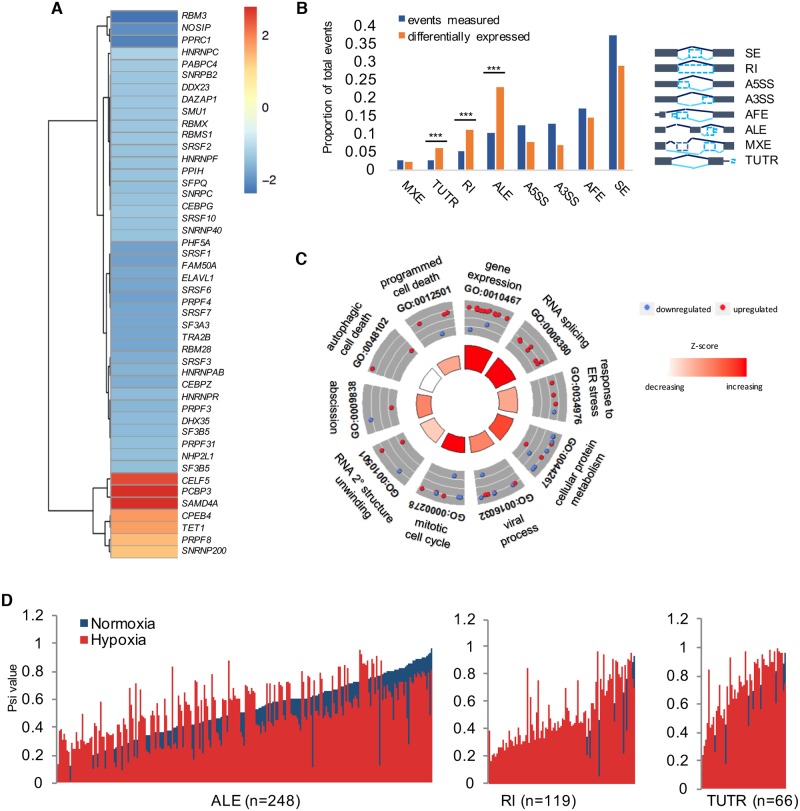
Classification of alternatively spliced mRNAs in hypoxic SQ20B cells.(A) Heatmap of RNA-processing and -splicing factors differentially expressed in hypoxia compared to normoxia (Fold-changes shown, false discovery rate [FDR] < 5%). (B) To the left, plot depicts number of events detected (blue) compared to events with significantly different expression in hypoxic compared to normoxic cells (red) (Bayes Factor ≥ 20, ΔѰ > 10%; Abbreviations: A3SS, alternative 3′ splice site; A5SS, alternative 5′ splice site; AFE, alternative first exon; ALE, alternative last exon; MXE, mutually exclusive exon; RI, retained intron; SE, skipped exon; TUTR, tandem 3′ untranslated region). Specific enrichment for changes in 3 event types are starred: ALE, RI, and TUTR (***P < 0.001, 2-sample test for equality of proportions). To right of graph, exon models of the types of splicing assessed by MISO analysis. (C) Gene ontology figure representing functional enrichment for hypoxia-induced changes in ALE, RI, and TUTR categories. (D) Percent spliced in (Psi) values plotted with hypoxia samples (red) overlaid against corresponding normoxic Psi values (blue). All supporting data used in the generation of this figure are included in S1 Data.